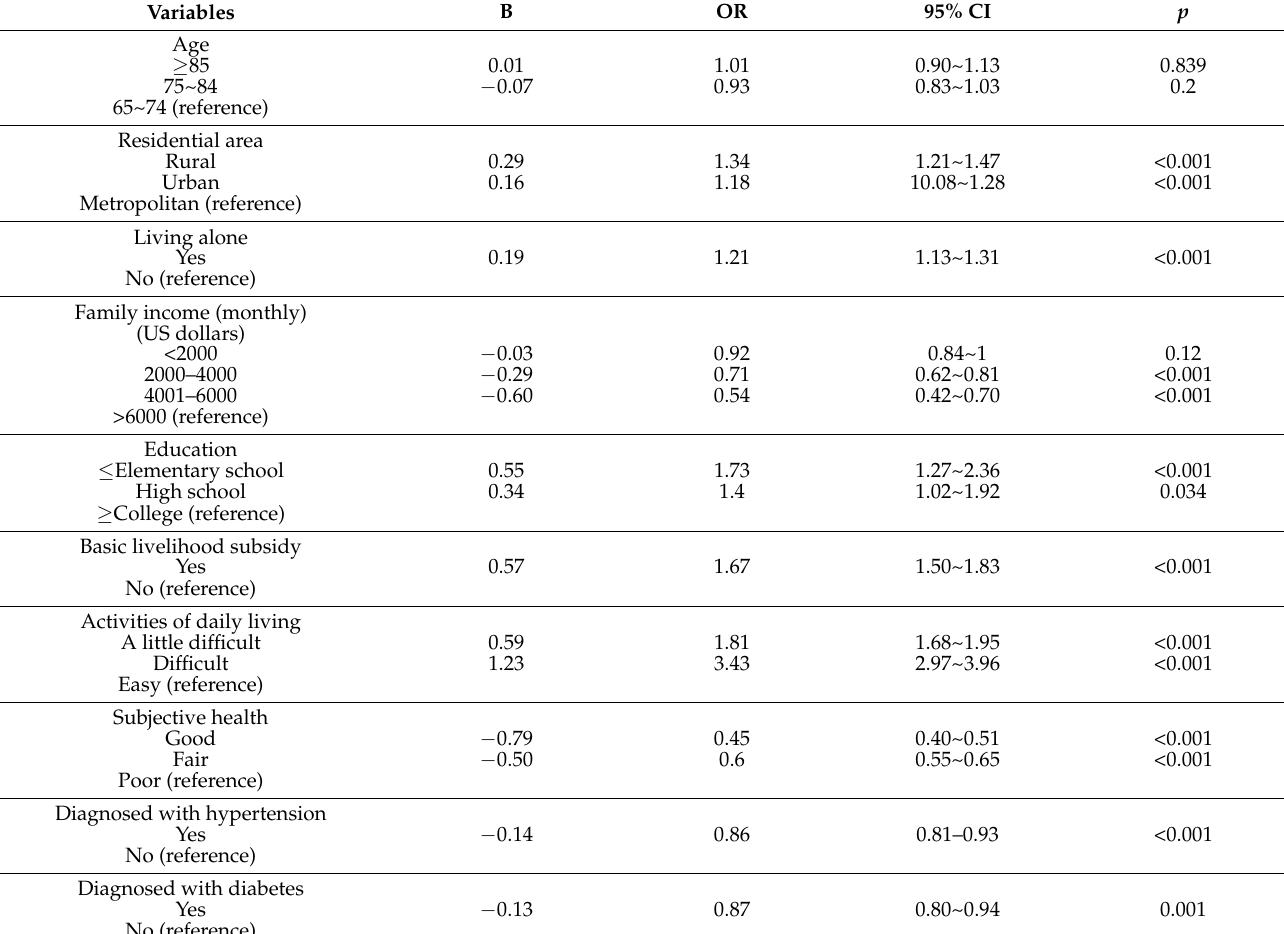
Table 3. Factors influencing unmet healthcare needs ( N =